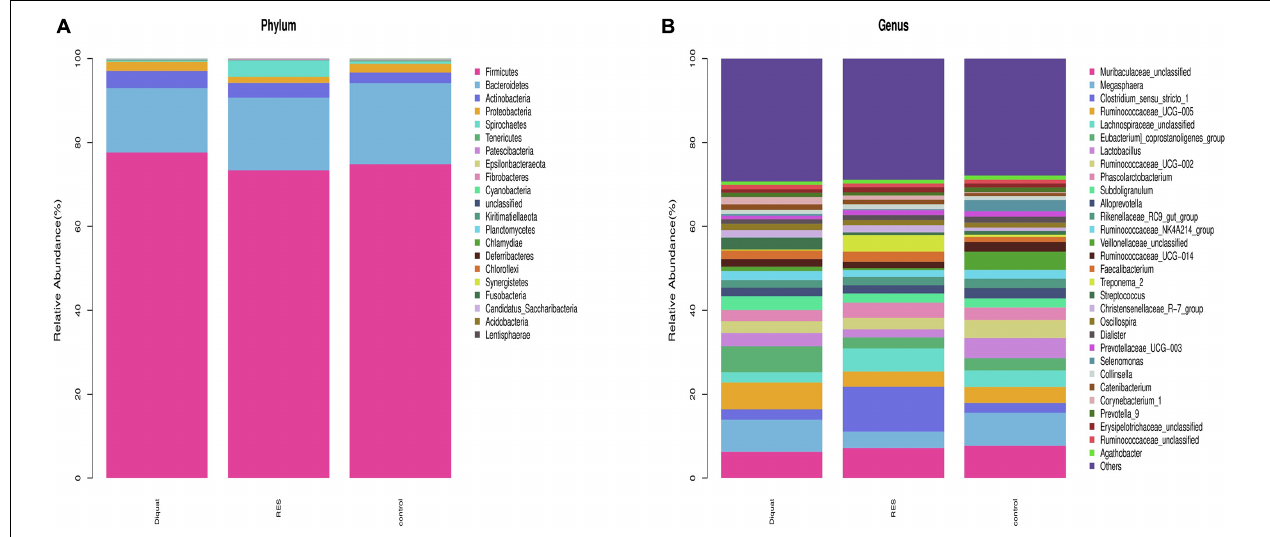
FIGURE 2 | Gut microbiome composition and abundance analysis. (A,B) Histogram of the top 30 at phyla (A) and genera (B) in each group.